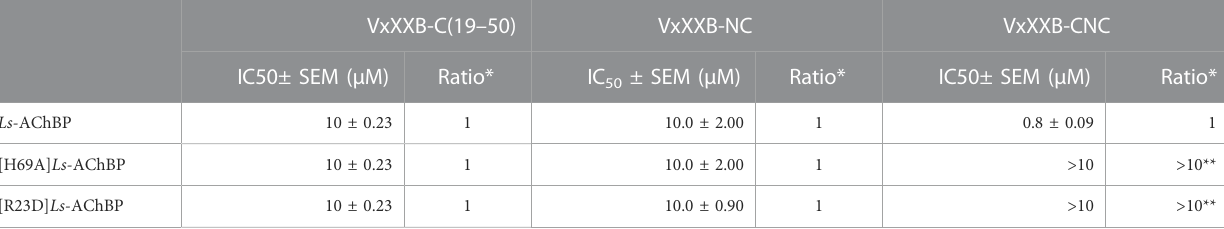
TABLE 2 IC 50 values for displacement of [ 3 H]-epibatidine binding to Ls -AChBPs and mutant Ls -AChBPs by CTD (19 – 50), VxXXB-NC and